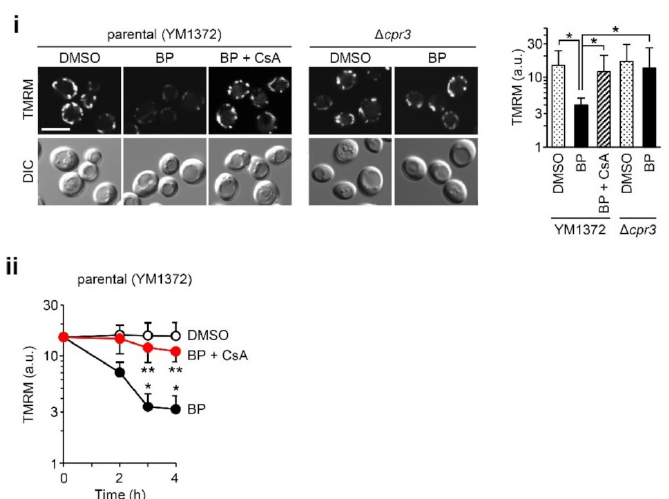
Figure 1. The effect of bisindolylpyrrole (BP) on the mitochondrial membrane potential in wild- type (YM1372) and Cpr3-deficient ( ∆ cpr3 ) yeast strains ( Saccharomyces cerevisiae ), pre-stained with 50 nM tetramethylrhodamine methyl ester (TMRM). ( i ) Left panels show confocal images for TMRM fluorescence signals at 4 h; representative fields were randomly imaged. Scale bar: 5 µ m. Right panel shows the quantification of TMRM fluorescence signals (data represent the mean ± SD from 100–150 cells; * p < 0.001 by Welch’s t -test with Bonferroni correction). The potential levels under 5 a.u. obtained by treatment with 0.5 µ M carbonyl cyanide 4-(trifluoromethoxy) phenylhydrazone (FCCP), an uncoupler, were considered to reflect depolarization. ( ii ) The time course of TMRM fluorescence over 4 h in the presence of DMSO (vehicle) or 5 µ M BP with or without 3 µ M cyclosporin A (CsA) in YM1372 (data represent the mean ± SD from 100–150 cells; * p < 0.001 relative to DMSO control; ** p < 0.001 relative to BP at the same time points, by Welch’s t -test).